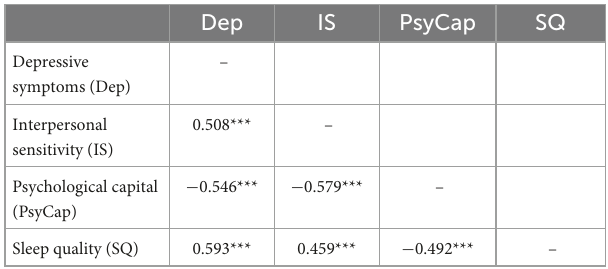
TABLE 2 Pearson’s correlation between variables.